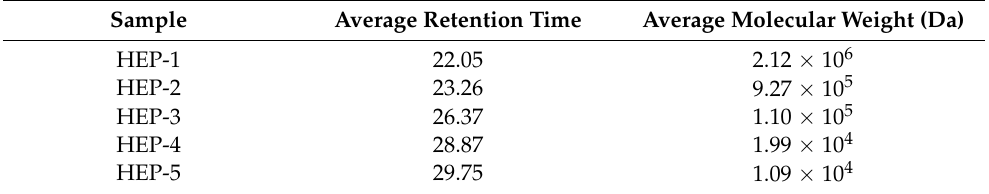
Table 1. Molecular weight of the HEP